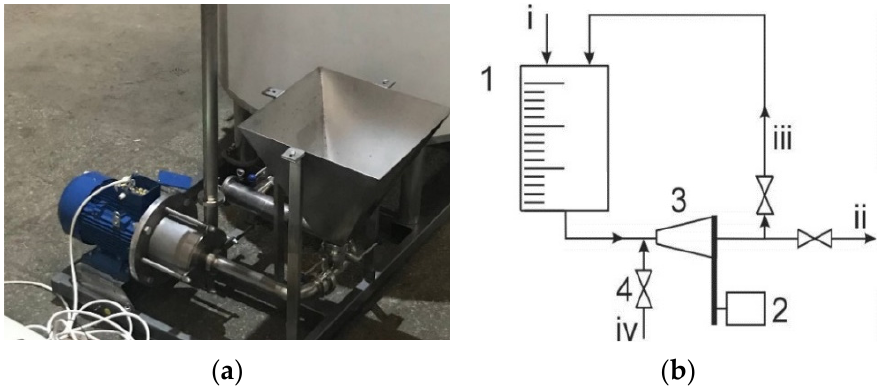
Figure 3. HSMD common view ( a ), homogeniser principal scheme ( b ), where: 1—peat-slurry tank; 2—electric motor; 3—HSMD; and 4—valve for extra component supply funnel (iv); i—water supply; ii—slurry output; and iii—recirculation flow.